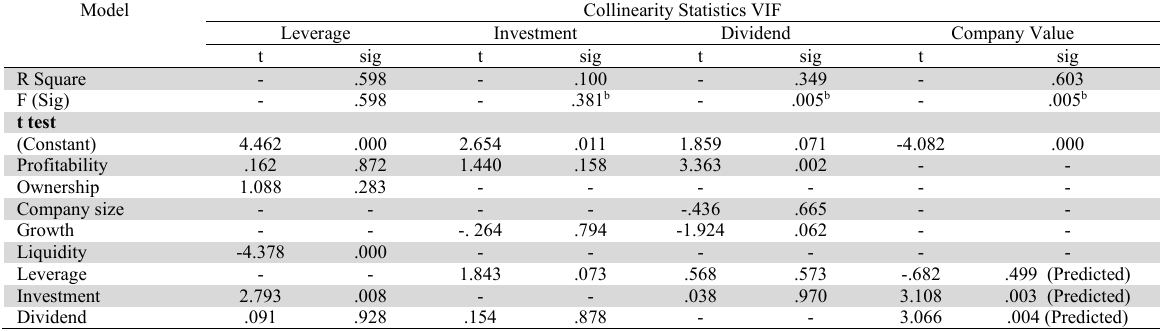
Determinant test results (R 2 ) and simultaneous (F) and Partial Test (t) equation of Leverage, Invest- ment, Dividend, Company